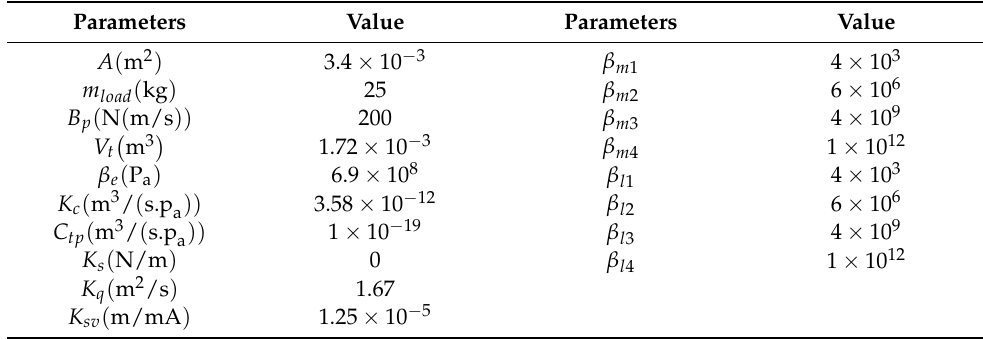
Figure 2. The bode plots of transfer functions between perturbation estimation and perturbation for two structure ESOs. Table 1. Parameters of the hydraulic system and